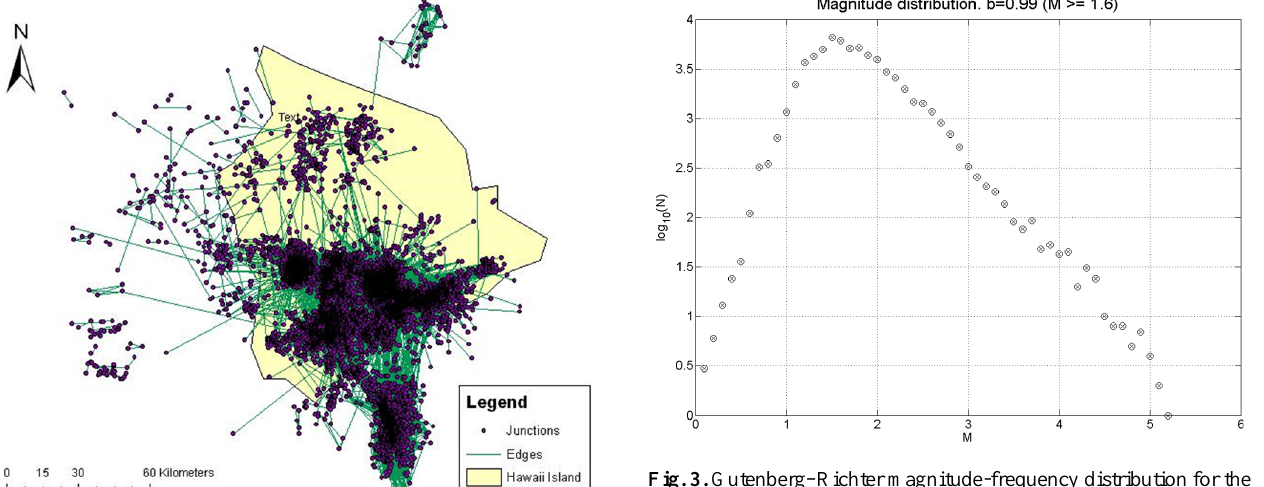
Fig. 3. Gutenberg–Richter magnitude-frequency distribution for the Hawaii data set ranging from 1 January 1989 to 31 December